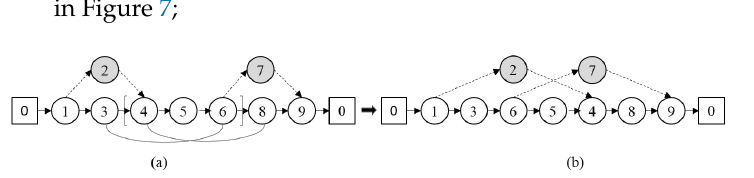
Figure 7. An example of an invalid TwoOpt move applied to the graph in ( a ), where origin node 3 is a truck node inside a sortie and the origin node 6 is a launch node for a different sortie, resulting in an invalid tour in ( b